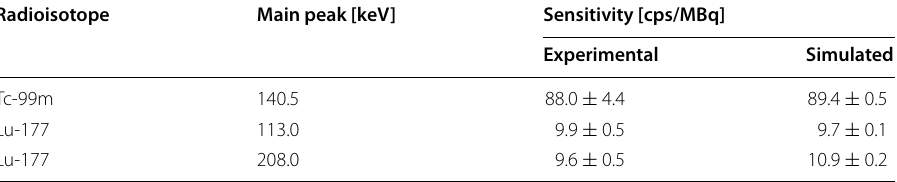
Table 8 Comparison of measured planar System Sensitivity with Monte Carlo results. All parameters have been measured at distance of 10 cm from collimator